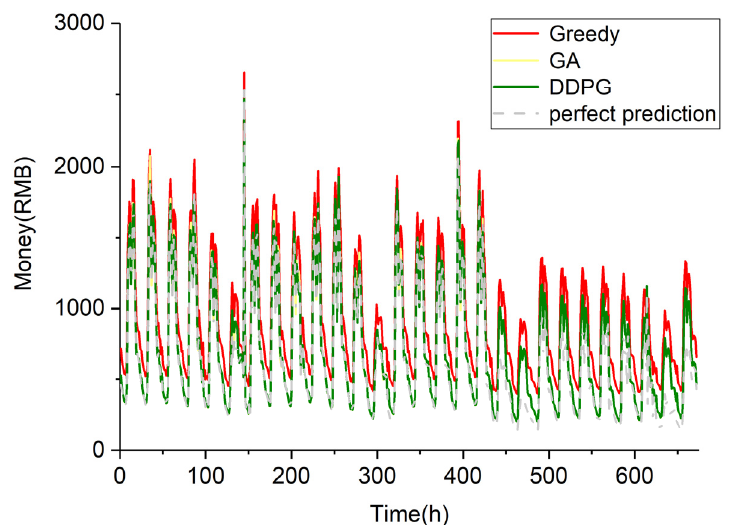
Figure 18. Change of money of perfect prediction and other methods.